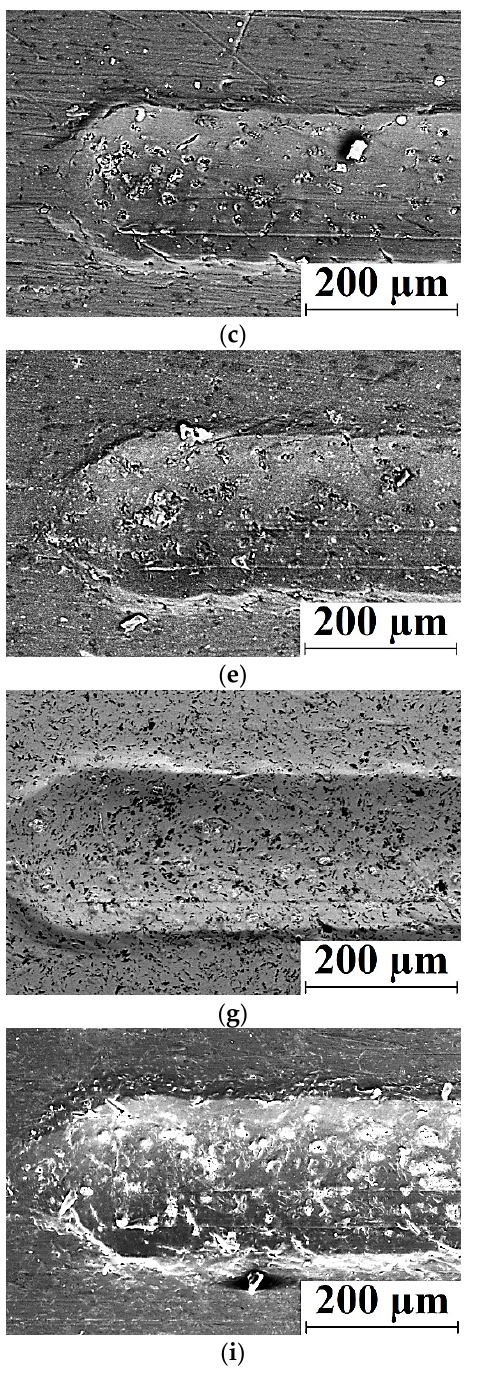
Figure 16. SEM-micrographs of the PI ( a , b ), PI/10CCF ( c , d ), PI/10CCF/10PTFE ( e , f ), PI/10CCF/10Gr ( g , h ), and PI/10CCF/10MoS 2 ( i , j ) composites after the scratch tests; increasing load.